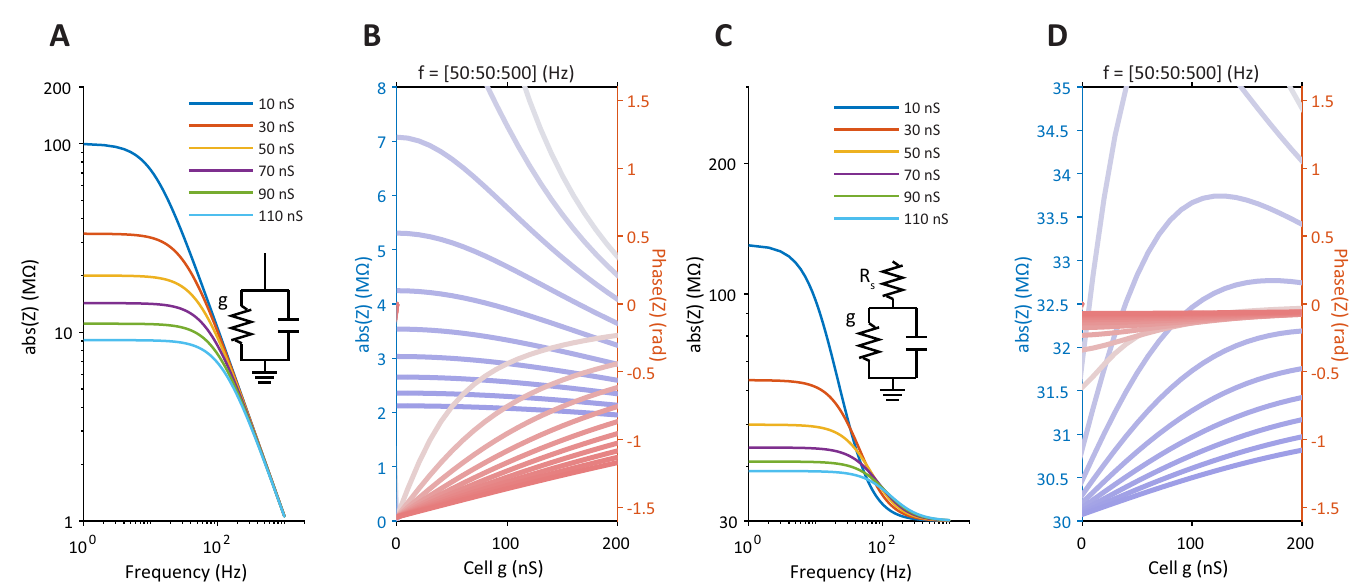
Fig 2. Impedance frequency-curves of passive electrical circuits for different conductances. A. Absolute impedance as a function of frequency for different values of the model conductance. Note that none of the curves intersect. B. Absolute impedance curves as function of conductance together with phase curves between real and imaginary parts of the impedance. Each line represents a different frequency (50Hz to 500Hz, steps of 50Hz, from lowest (pale blue or red) to highest (deep colors) as indicated by the text (Fr = [50:50:500]) above. Also presented are phase curves between voltage and current for the same frequencies. C-D. The same but when the RC circuit is also connected in series to a resistor (R s ). Note in c that curves intersect each other at high frequencies and in d that the phase is almost constant. Fixed circuit parameters: R s = 30M Ω , C = 0.15nF.